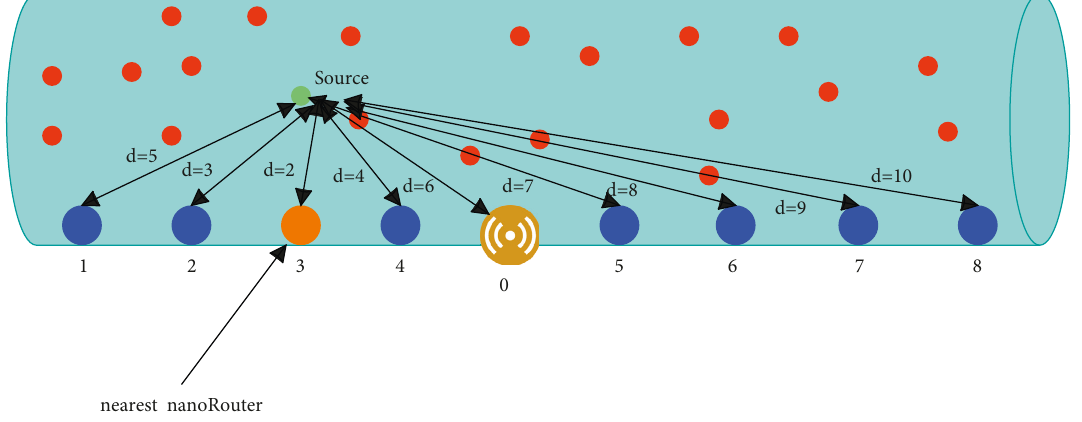
Figure 14: Selection of nanorouter.